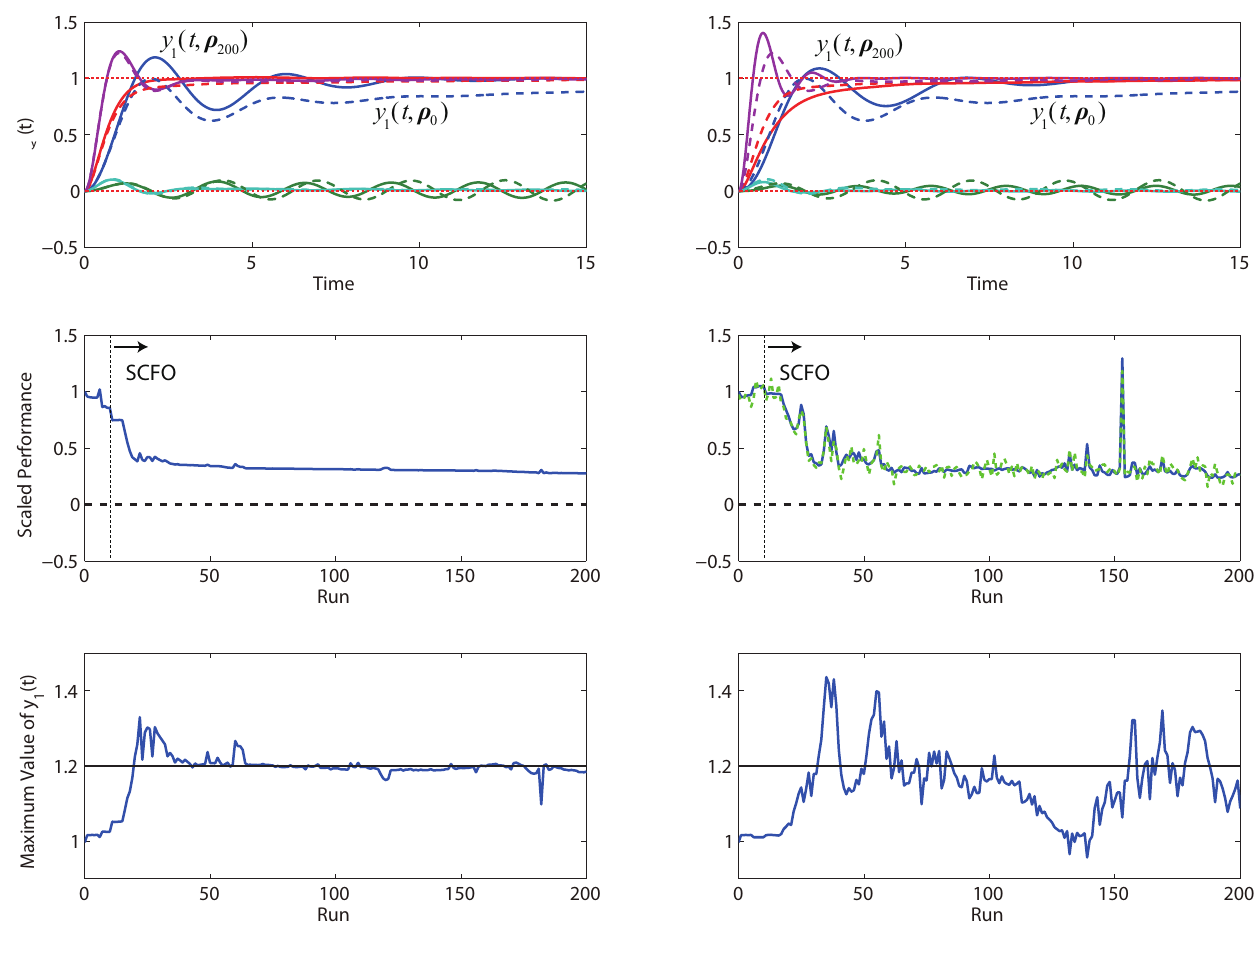
Figure 17. Performance obtained by iterative tuning for the system of PI controllers in Problem (22) (without an output